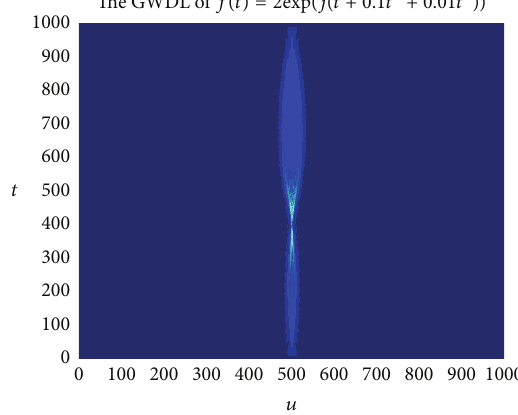
Figure 4: 𝑡 - 𝑢 distribution of QFM signal in GWDL